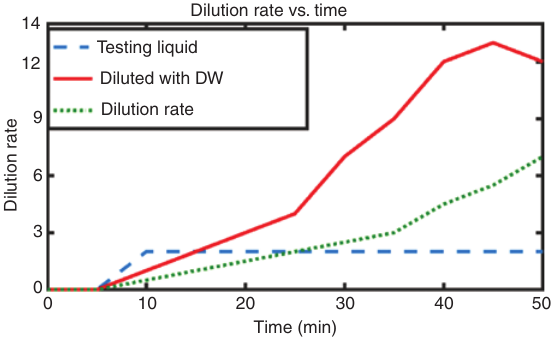
Figure 9: Testing the liquid dilution ratio.